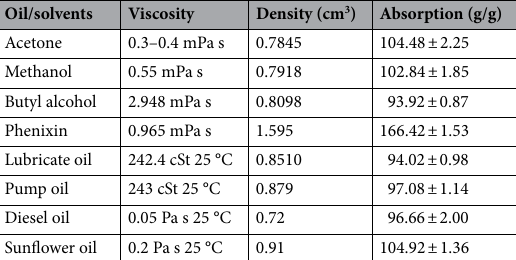
Table 1. Absorption capacity of OTS-PDA-MS for oil/solvents with different viscosities and densities.